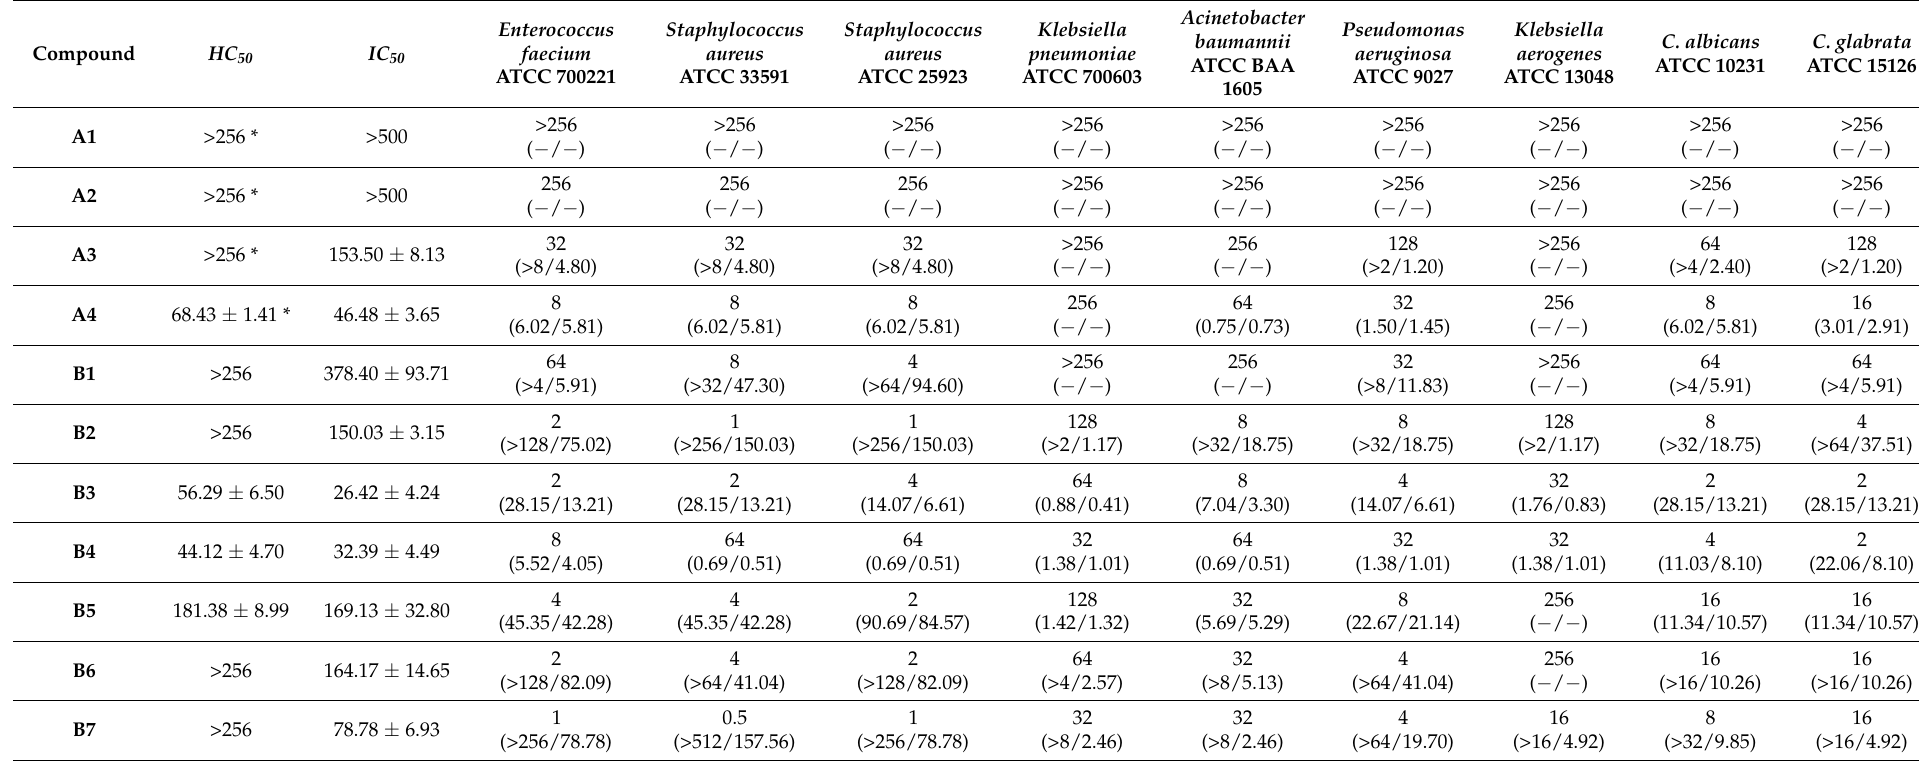
Table 2. Hemolysis (HC 50 ), cytotoxicity (IC 50 ), and antimicrobial activity against planktonic cultures. The selectivity indexes (SI) human red blood cells (hRBCs) and immortalized human keratinocytes cell line SI HaCaT are in brackets on the left and right,